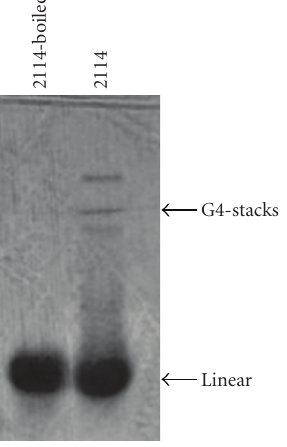
Figure 1: Class B INH-ODN 2114 can undergo G4-stacking in the presence of potassium ions. INH-ODN 2114 (1 μ g) was dissolved in a bu ff er containing potassium ions at 65 degrees for 10 minutes and then slowly cooled down to room temperature for 2 hours. For comparison, the same ODN was dissolved in Tris-EDTA, boiled for 10 minutes and rapidly cooled on ice. Electrophoretic mobility on 20% native PAGE gel is shown. Gel was stained with Stains All